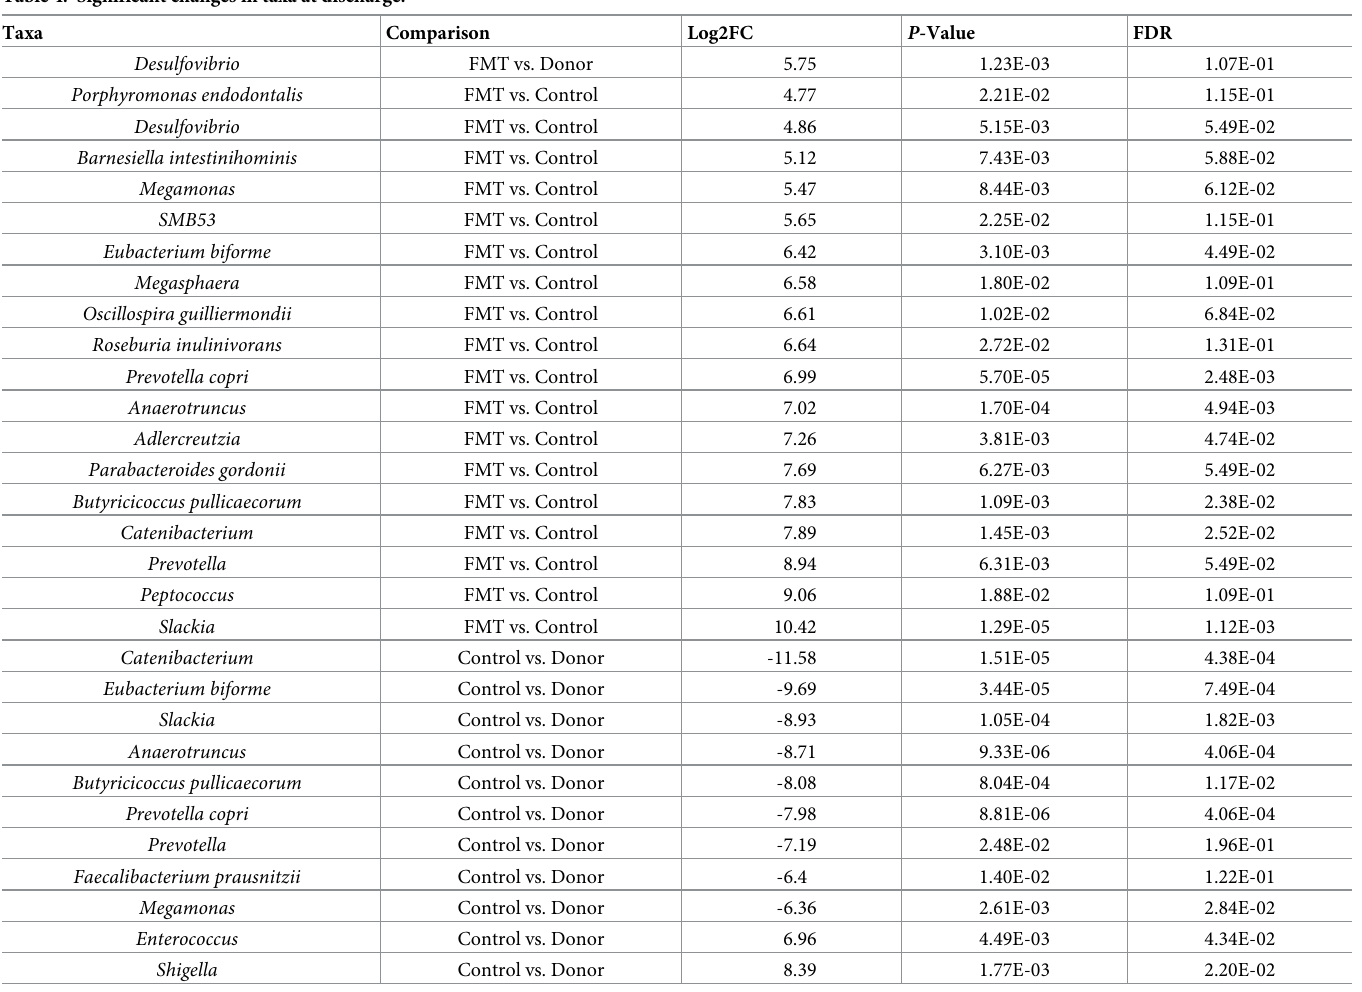
Table 4. Significant changes in taxa at